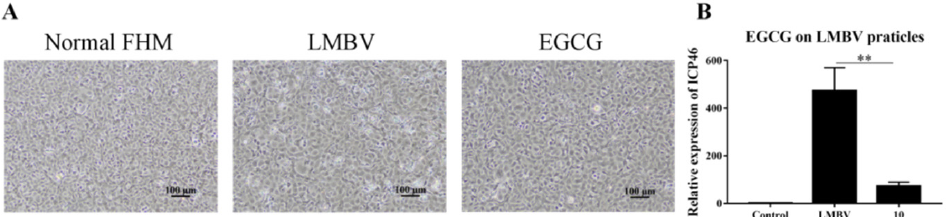
Figure 3. Action of EGCG against LMBV particles based on RT-qPCR analysis and light microscopy observations. ( A ) CPEs in FHM cells incubated with purified virus pretreated with EGCG were less abundant than in cells incubated with virus alone. ( B ) The expression level of ICP46 in the EGCG pretreatment group was significantly lower than that in the purified LMBV group without EGCG. ** indicates p <